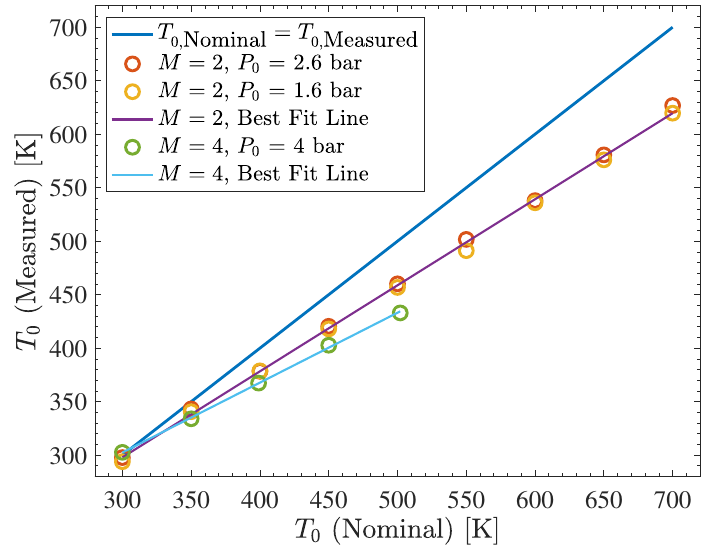
Figure 14. Average steady-state results for T 0 for Mach 2 and Mach 4